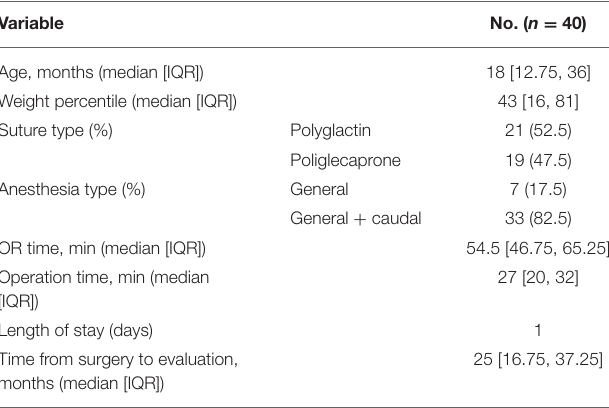
TABLE 1 | Patients’ clinical